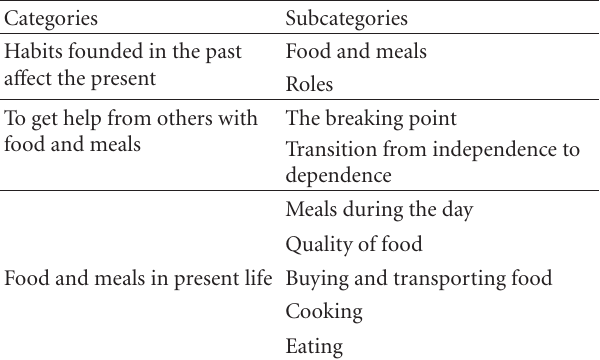
Table 2: Categories and subcategories regarding home-living elderly people’s views of food and